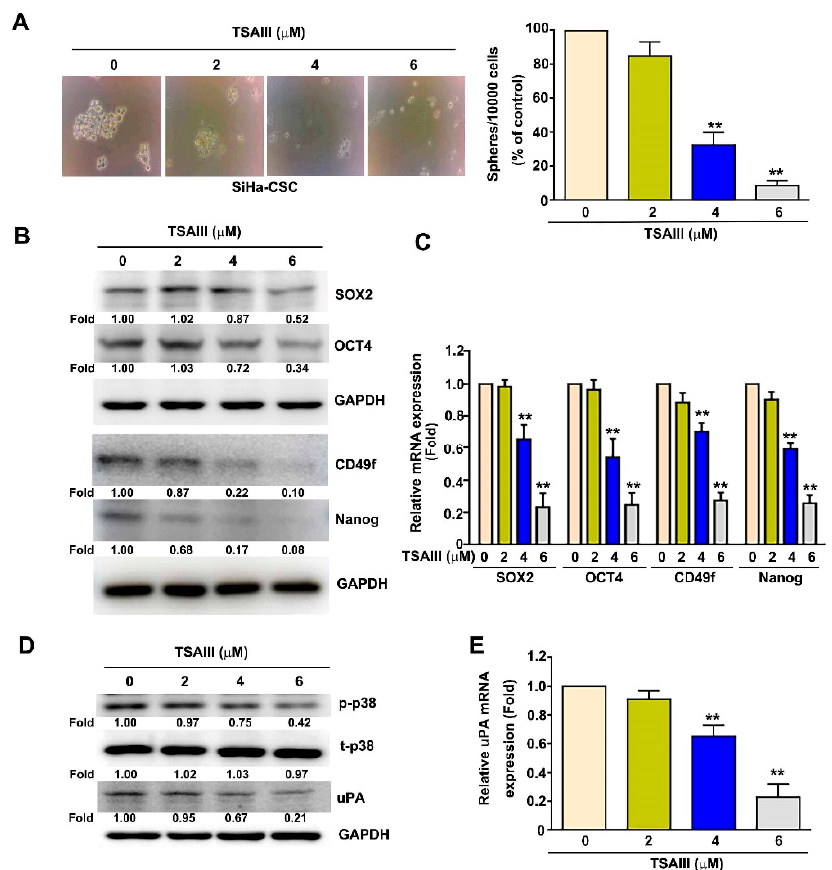
Figure 7. TSAIII regulation of cancer stemness, p38 MAPK activation and uPA expression in human cervical cancer stem cells. Human SiHa cervical cancer stem cells were treated with various concen- trations of TSAIII (0, 2, 4 and 6 µ M) for 24 h and then harvested to observe the 3D sphere formation ( A ) and detect the expression of stemness factors SOX2, OCT4, Nanog and CD49f via immunoblotting ( B ) and RT-qPCR ( C ) assays. ( D , E ) After TSAIII (0, 2, 4 and 6 µ M) treatment, t-p38 (total-p38), p-p38 (phosphoryled-p38) and uPA expression were then measured via immunoblotting and RT-qPCR assays. GAPDH as internal control. ** p < 0.01 versus control (line 1) (mean ± SE, n = 3). Uncropped WB images were shown in Figure